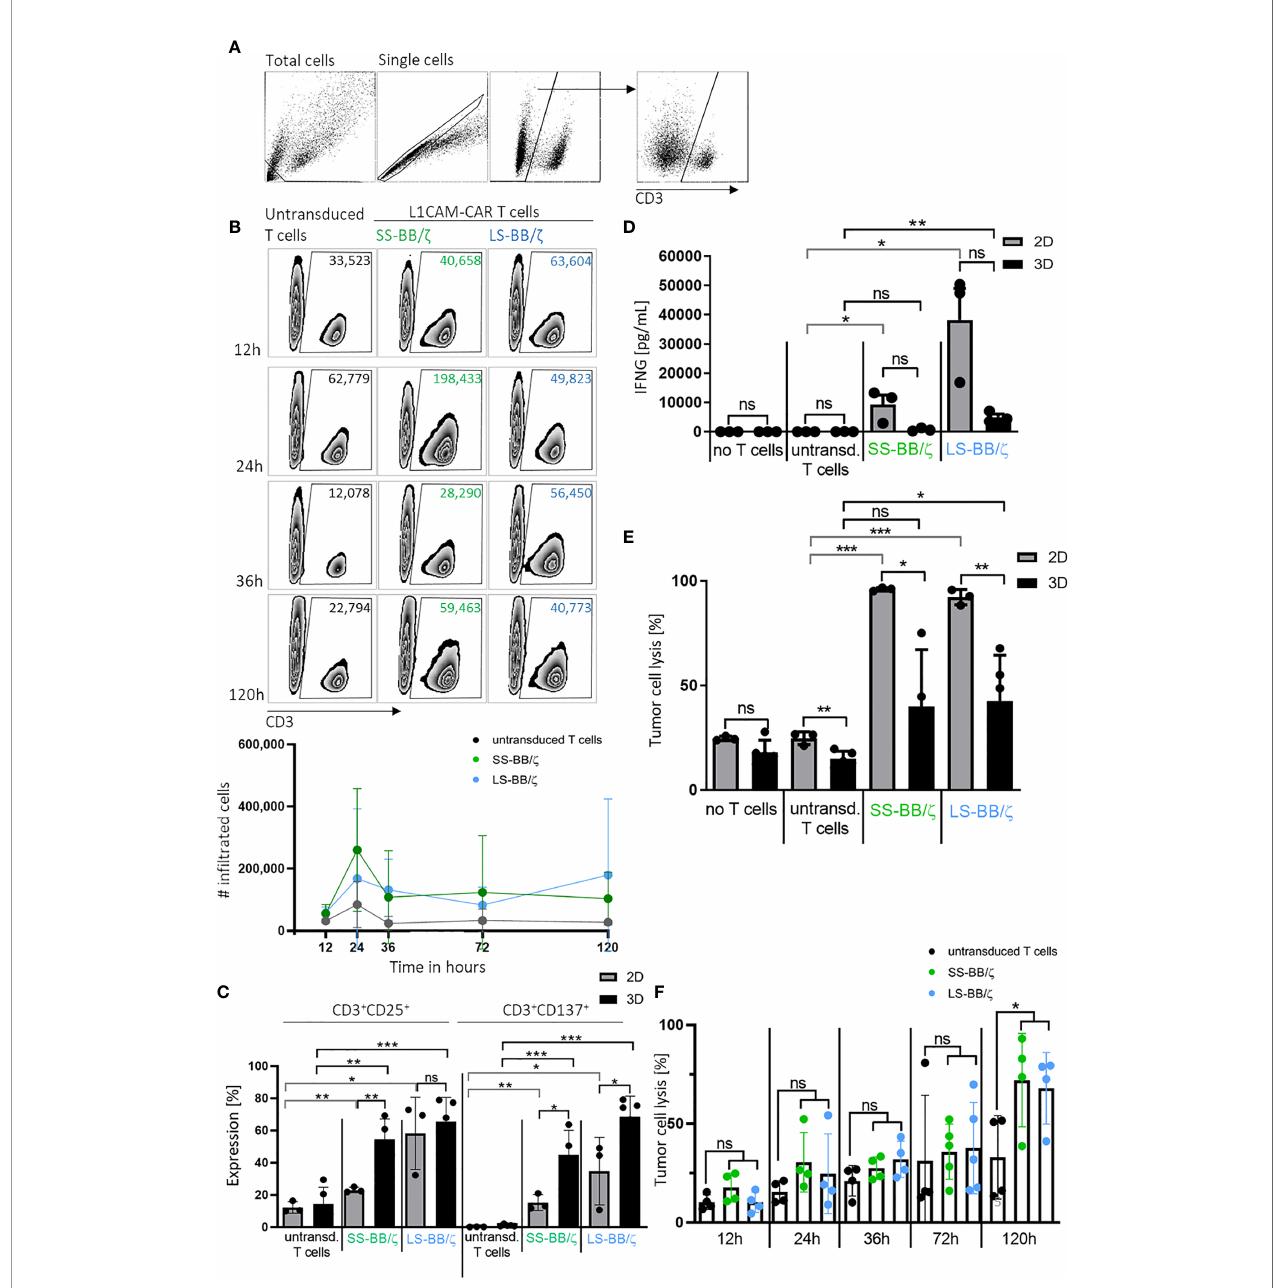
FIGURE 5 | L1CAM-CAR T cells in fi ltrate and are highly activated in bioprinted 3D neuroblastoma tumor models. (A) Gating strategy for fl ow cytometry (applied with FlowJo_V10) is shown. Gates are applied to distinguish single viable T (CD3 + ) and tumor cells (CD3 - ) within the total cells. (B) Representative zebra plots showing numbers of CD3 + viable cells that in fi ltrated the 3D tumor model after the indicated time measured by fl ow cytometry with precision counting beads including summary of 3 biological replicates. (C) Surface activation markers were fl ow cytometrically analyzed on untransduced T cells and L1CAM-speci fi c CAR T cells after 24h of tumor cell interaction (effector:target ratio of 5:1) in either 2D coculture or the bioprinted 3D model. Depicted are double-positive cells for CD8 + and CD25 or CD137. Cells were gated from living single cells. Bars depict the mean of 3 (2D) or 4 (3D) experiments with error bars representing SD. (D) Interferon gamma (IFNG) released into the culture media was detected by ELISA after 24h of tumor cell interaction (effector:target ratio of 5:1) in either 2D coculture or the bioprinted 3D model. Bars depict the mean of 3 (2D) or 4 (3D) experiments with error bars representing SD. (E) Tumor cell cytotoxicity was analyzed (FACS) after 24h of tumor cell interaction (effector:target ratio of 5:1) in either 2D coculture or the bioprinted 3D model. Bars depict the mean of 3 (2D) or 4 (3D) experiments with error bars representing SD. (F) FACS-based tumor cell cytotoxicity is shown for the 5-day time course in the bioprinted 3D model after addition of untransduced T cell controls or L1CAM-speci fi c CAR T cells, as indicated. Experiments tested L1CAM-speci fi c CAR T cells with either the short (green) or long (blue) spacer. Bars depict the mean of 4 experiments with error bars representing SD. ns, not signi fi cant, *p ≤ 0.5, **p ≤ 0.01, ***p ≤